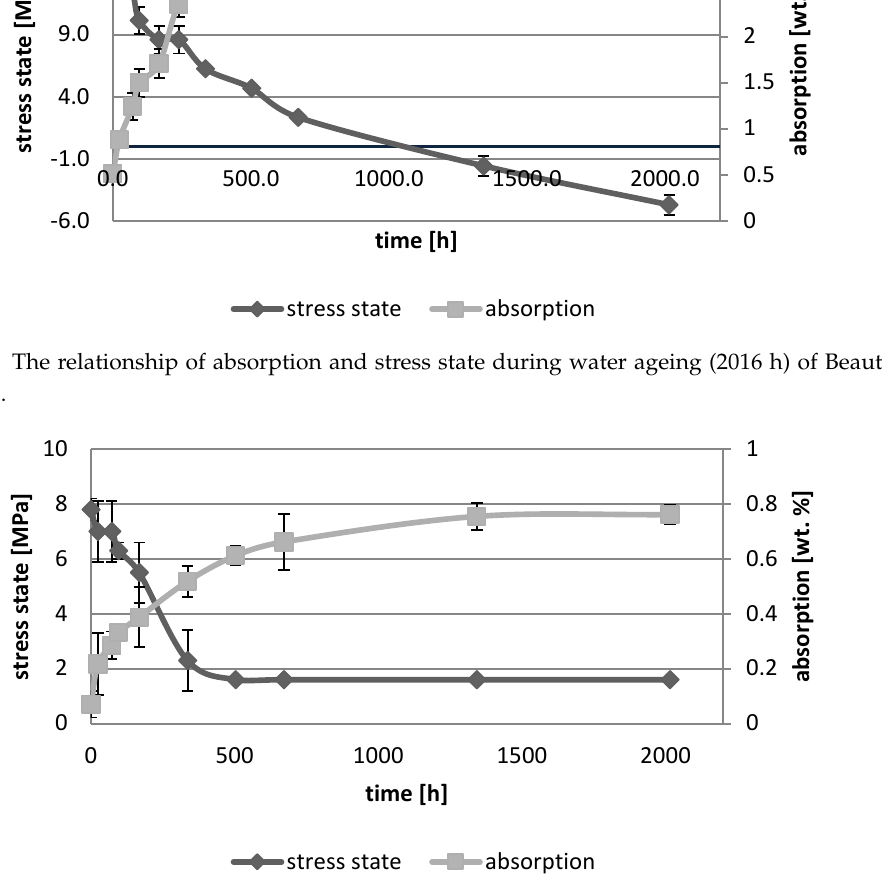
Figure 5. The relationship of absorption and stress state during water ageing (2016 h) of Compoglass Flow.